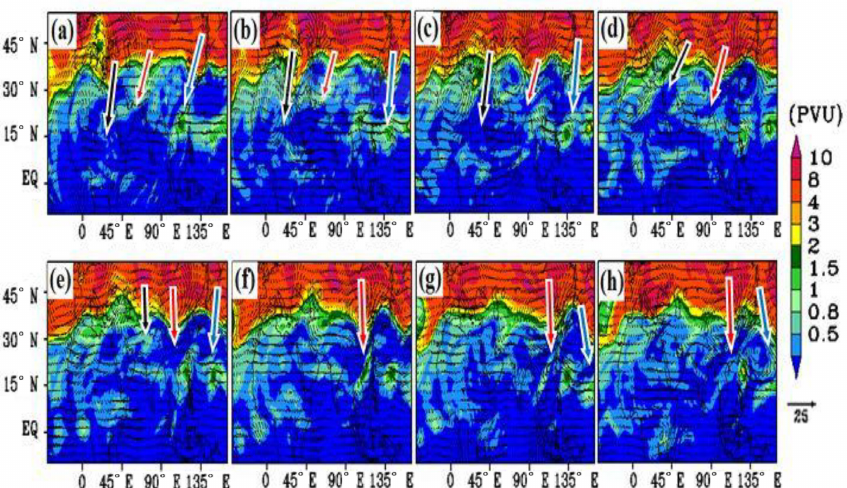
Figure 2. Spatial distribution of potential vorticity (PVU) (colour shades) at 350K potential temperature surface and wind anomalies in ms − 1 (thin black vectors) at 200hPa from ERA-Interim reanalysis for (a) 1 July, (b) 2 July, (c) 3 July, (d) 4 July, (e) 5 July, (f) 6 July, (g) 7 July and (h) 8 July 2003. The events of RWB-1, RBW-2 and RWB-3 are indicated by solid black, red and blue arrows,